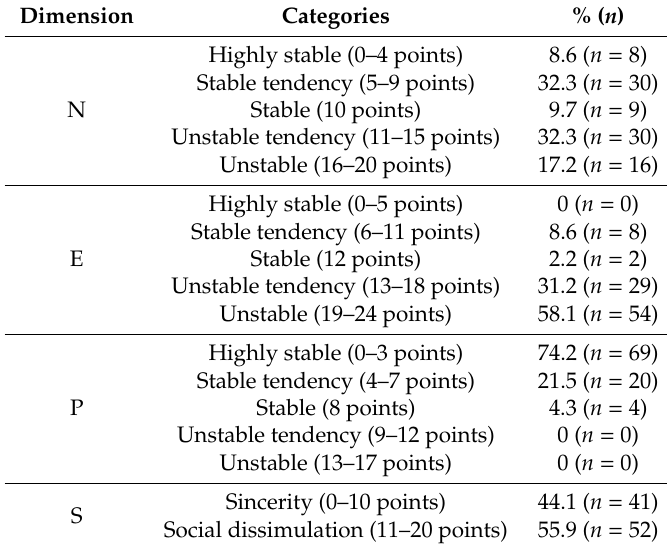
Table 2. Descriptive data on the personality variables according to EPQ-J